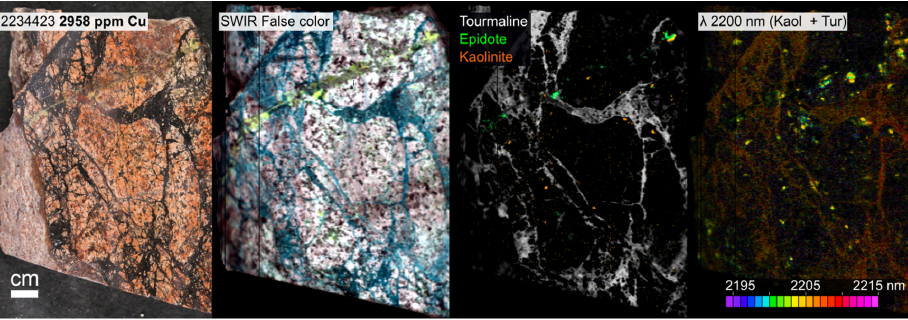
Figure A5. Sample 2234423, tourmaline breccia.